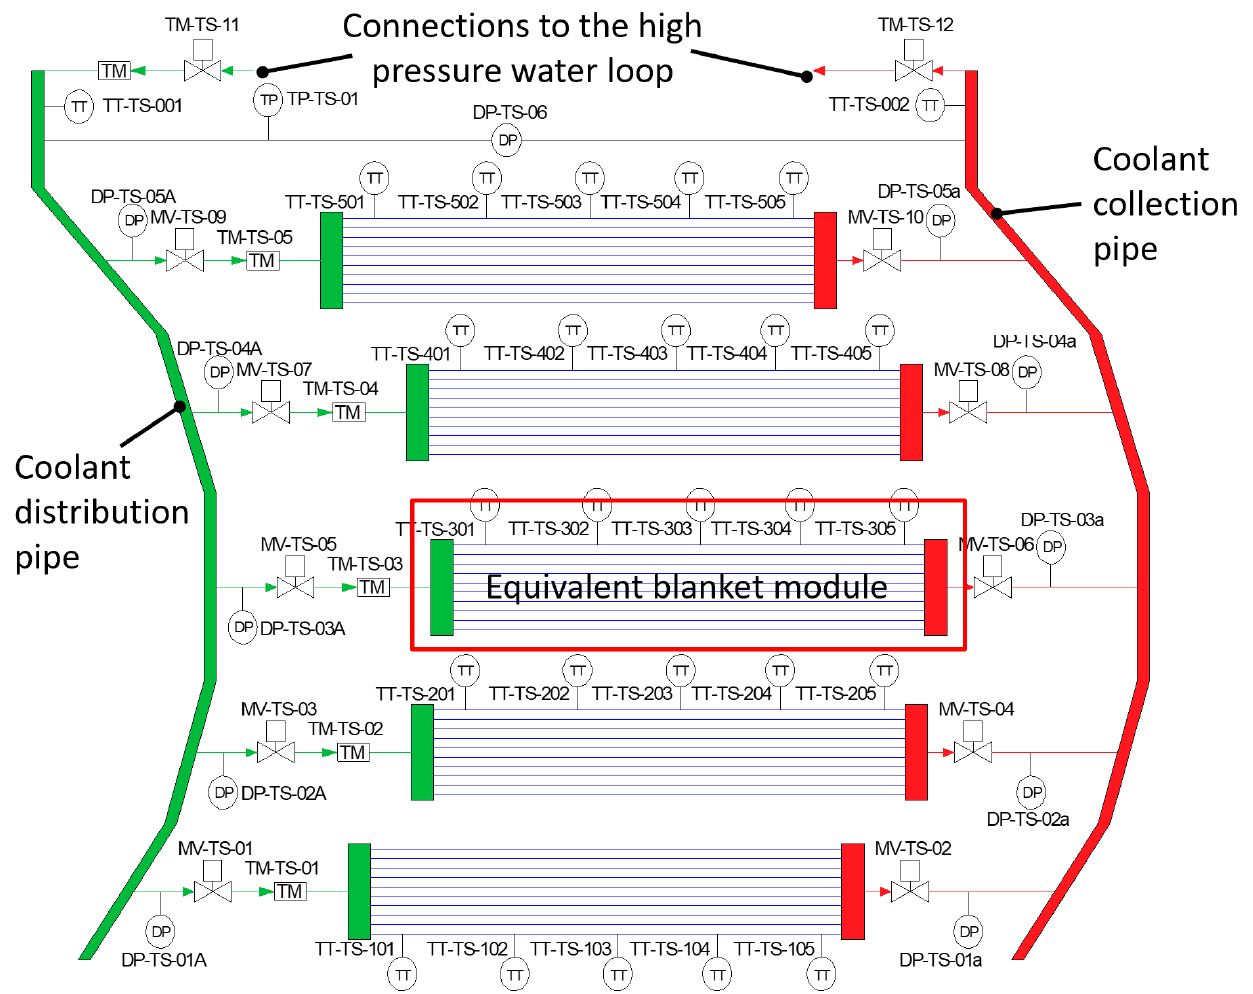
Figure 5. Schematic view of the flow instability test section.